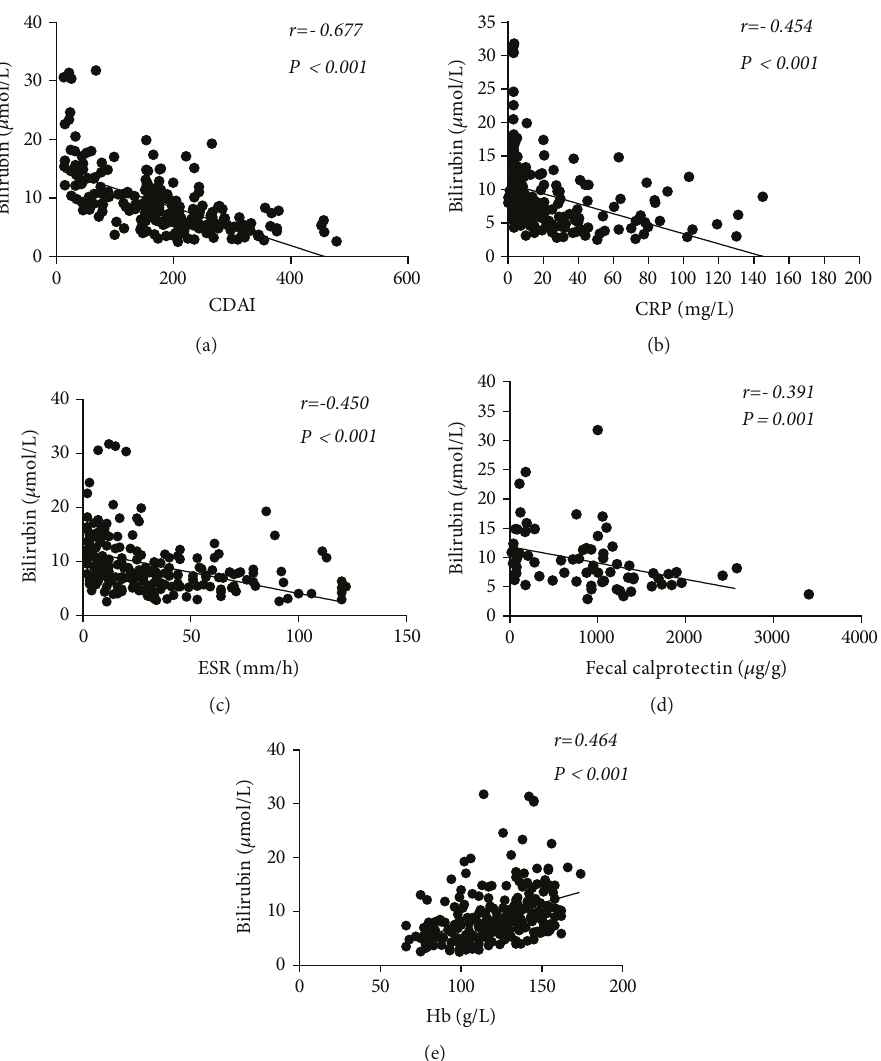
Figure 2: The correlation between serum bilirubin levels and (a) CDAI score ( n = 224 ), (b) CRP level ( n = 224 ), (c) ESR ( n = 213 ), (d) FC ( n = 70 ), and (e) Hb level ( n = 242 ) in CD patients by using a scatter